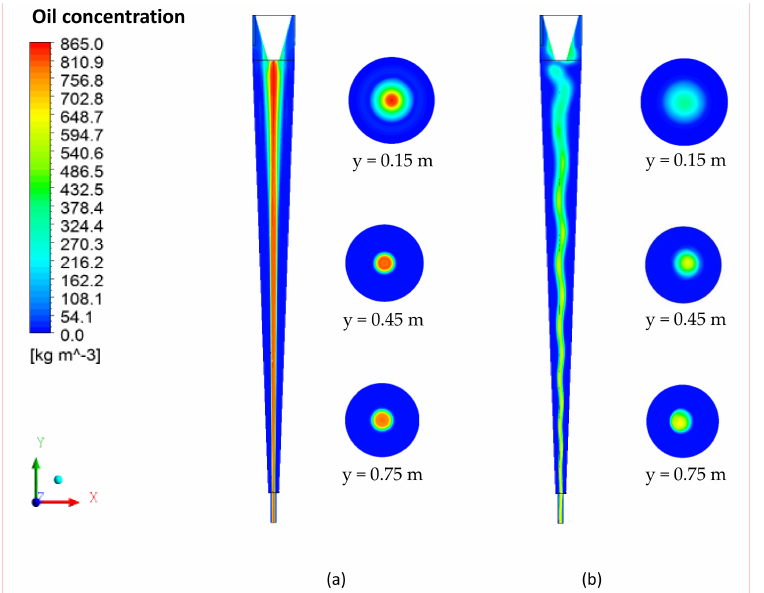
Figure 11. Oil concentration field in the yx and xz planes at positions y = 0.15 m, y = 0.45 m and y = 0.75 m. ( a ) Conventional cyclonic separator and ( b ) filtering cyclonic